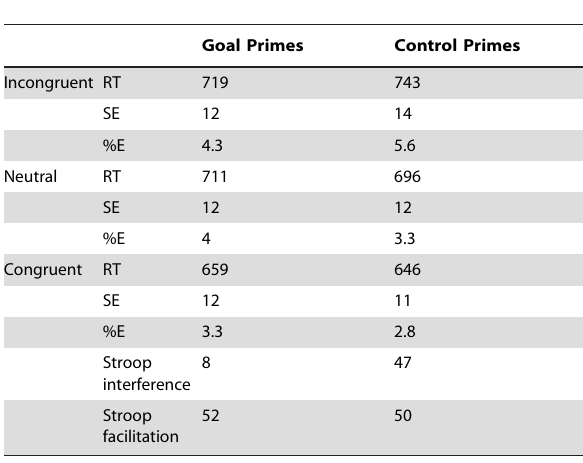
Table 1. Reaction times (ms), standard errors (SE) and percentage of